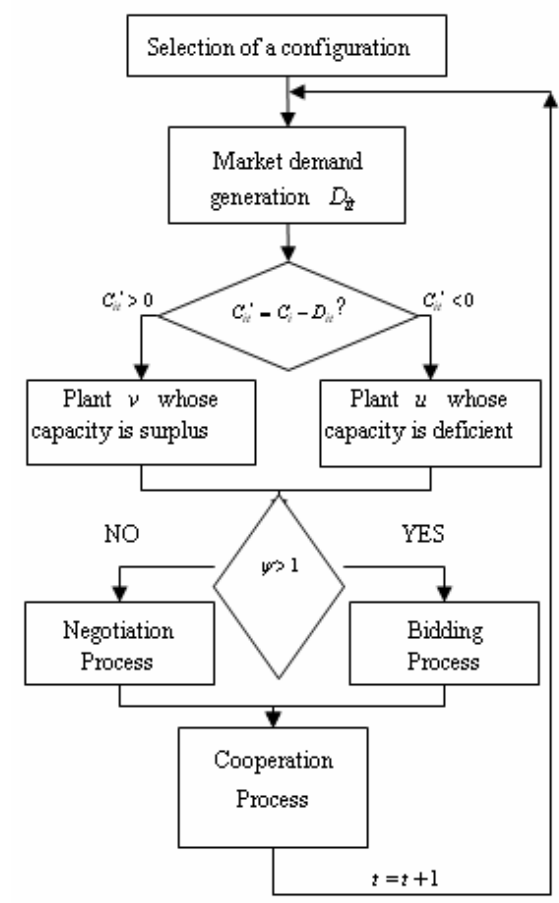
Fig. 1.2. Simulation process of flexibility